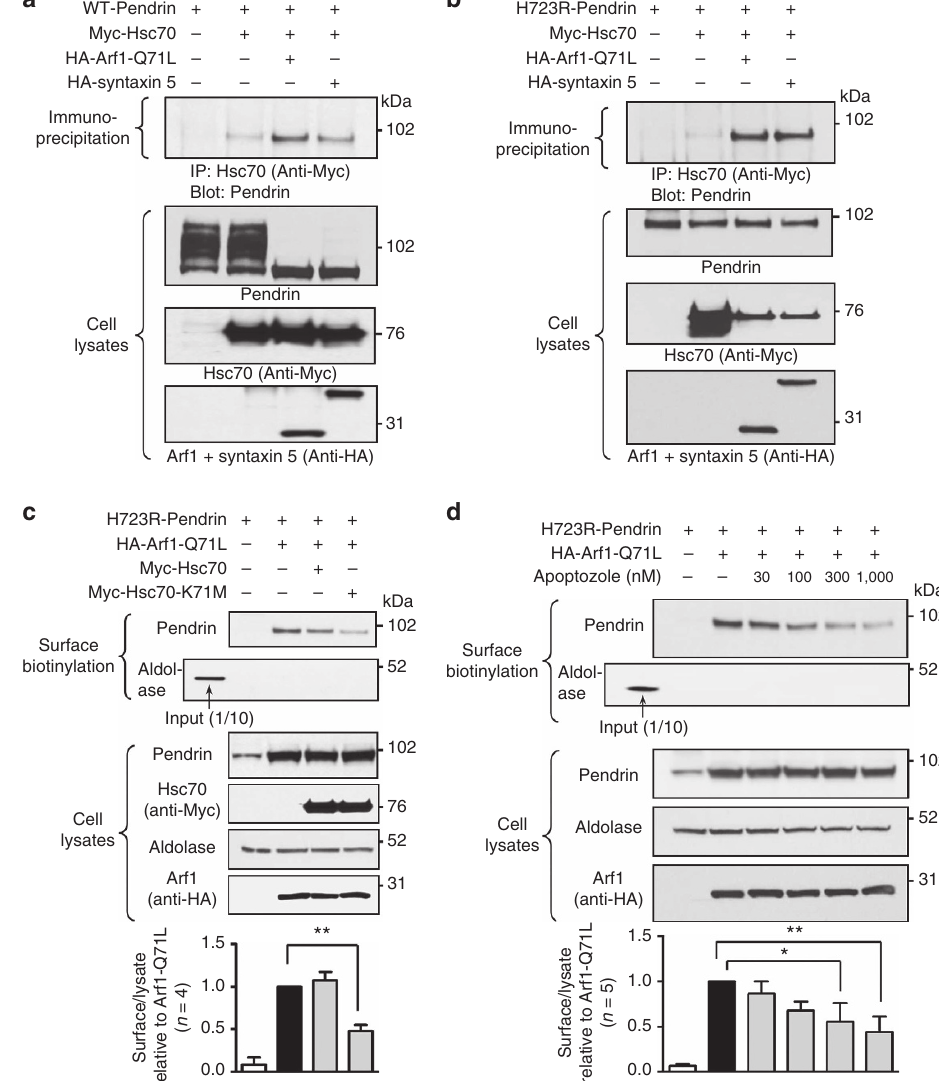
Figure 4 | Physical interaction with Hsc70 and Hsc70 ATPase activity are necessary for unconventional surface trafficking of H723R-pendrin. ( a , b ) Lysates of PANC-1 cells transfected with indicated plasmids were immunoprecipitated with anti-Myc (Hsc70) and immunoblotted. Both and WT- ( a ) and H723R- ( b ) pendrins strongly interacted with Hsc70 when ER-to-Golgi traffic was blocked by Arf1-Q71L or syntaxin 5 overexpression. ( c ) Inhibition of Hsc70 ATPase activity by overexpression of Hsc70-K71M (ATPase activity-ablated dominant-negative mutant) inhibited the surface expression of unconventionally transported H723R-pendrin. ( d ) Hsc70 ATPase activity inhibitor apoptozole dose-dependently reduced Arf1-Q71L-induced surface expression of H723R-pendrin. * P o 0.05, ** P o 0.01 by one-way analysis of variance, the number of replicates ( n ) is presented in each panel. Unprocessed original scans of western blots are shown in Supplementary Fig.